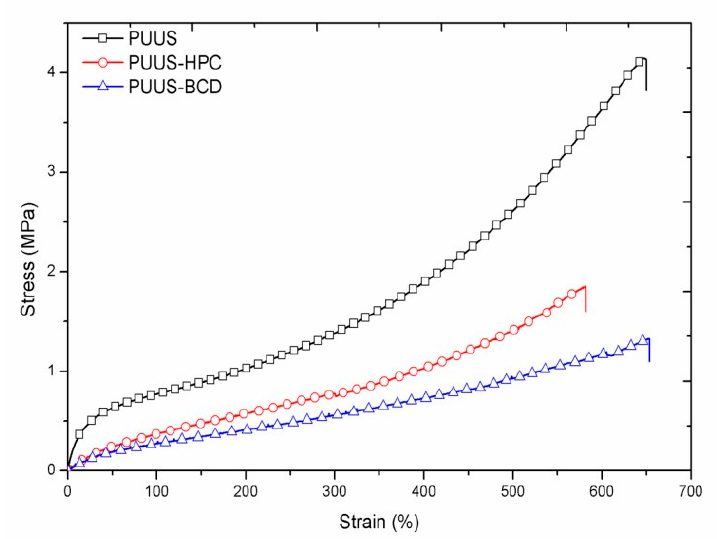
Figure 7. Stress–strain curves of the nanofibrous mats (PUUS) and nanofibrous composite mats (PUUS-HPC and PUUS- β CD).